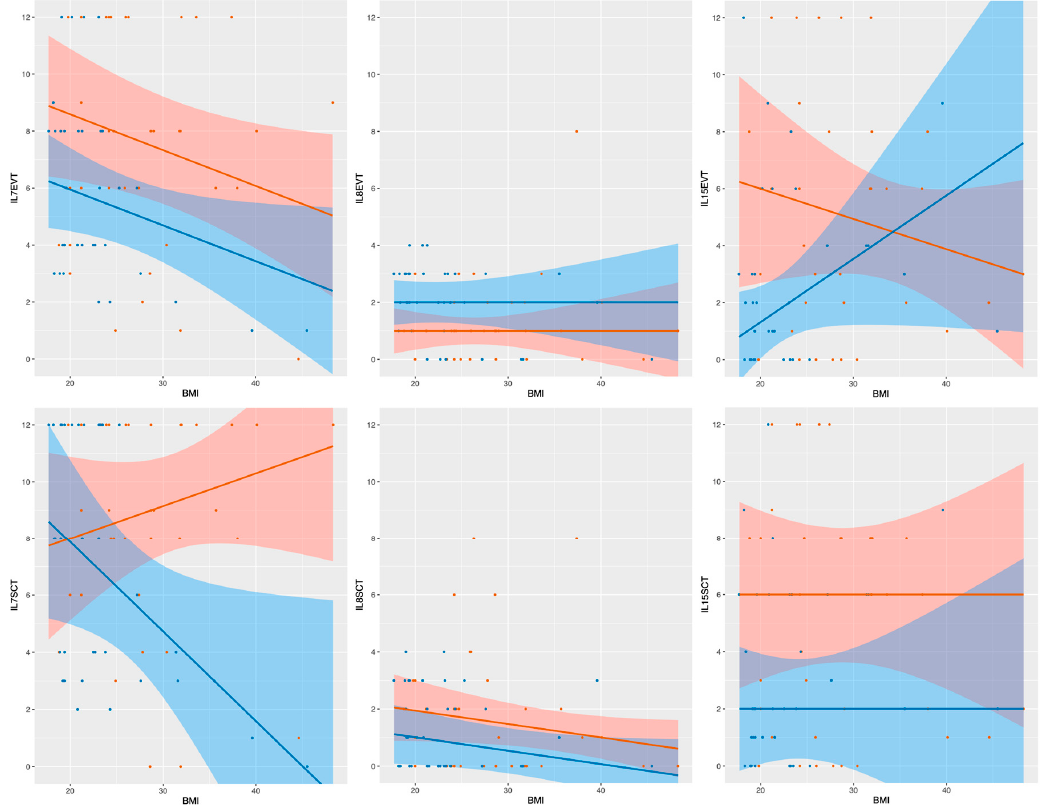
Figure 4. This figure shows the respective interleukin expression depending on being GDM positive or negative and the maternal BMI before pregnancy. The y axis shows the respective interleukin expression using the IRS. The x axis shows the BMI. The regression lines of each model of median regression are orange for the GDM positive group and blue for the GDM negative control group. The 95% confidence interval of each group is in the same colors. Every dot describes one case. In the plots of IL7 SCT and IL15 EVT the statistically significant interaction of both variables is shown. The remaining four figures show the interleukin expression depending on the BMI without interaction of those two variables. Table 2. Linear Median Regression Models for Interleukin Expression Including BMI and GDM.